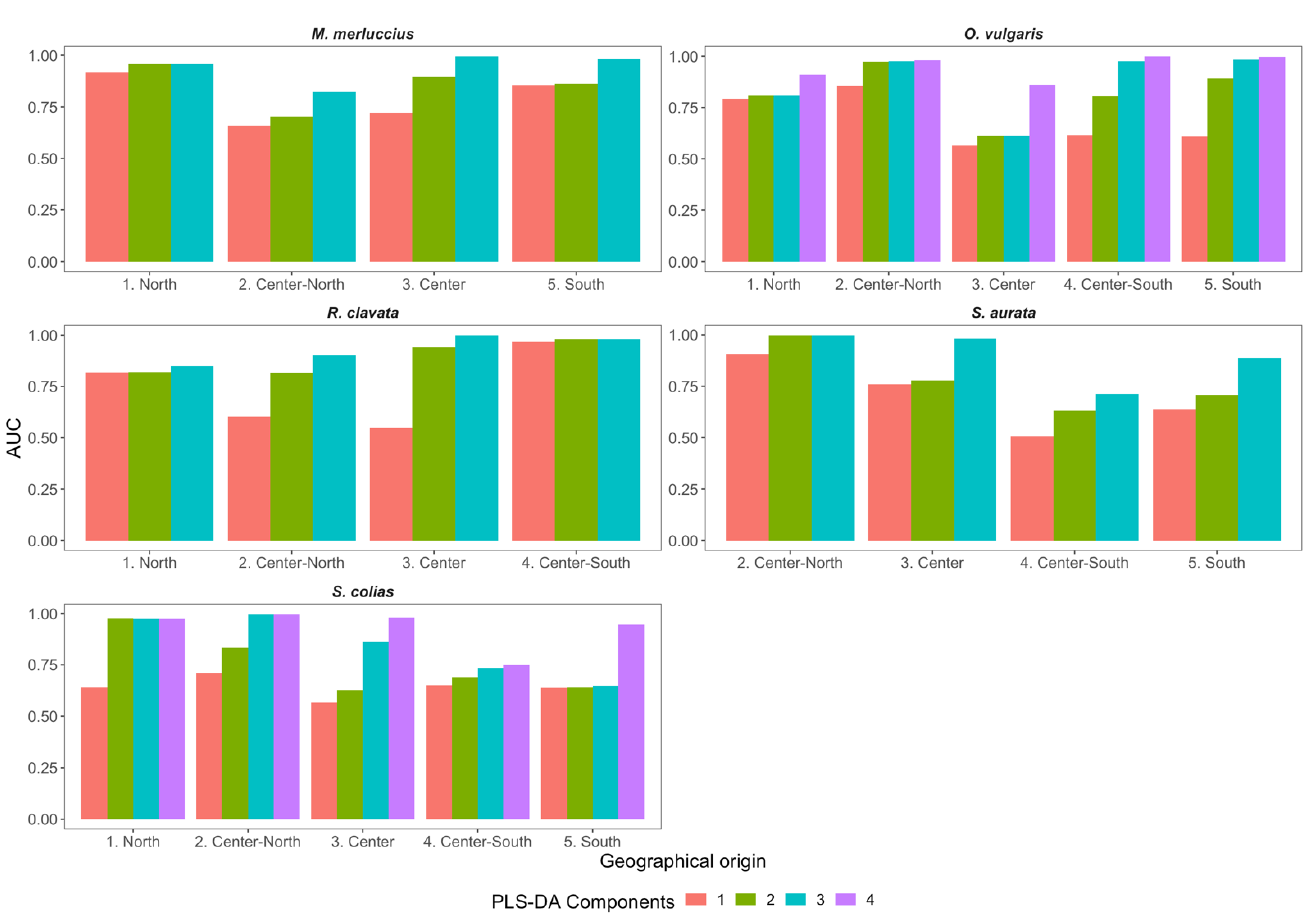
Figure 4. Area under the curve (AUC) of the receiver operating characteristic (ROC) curve of the partial least-squares discriminant analysis (PLS-DA), having as input the processed (Savitzky–Golay first-order differentiation filter) X-ray fluorescence reflectance spectra, conducted for each species ( Merluccius merluccius , Octopus vulgaris , Raja clavata , Sparus aurata, and Scomber colias ) and sample geographical origin and number of components. Results for the number of components above k − 1 are not shown.